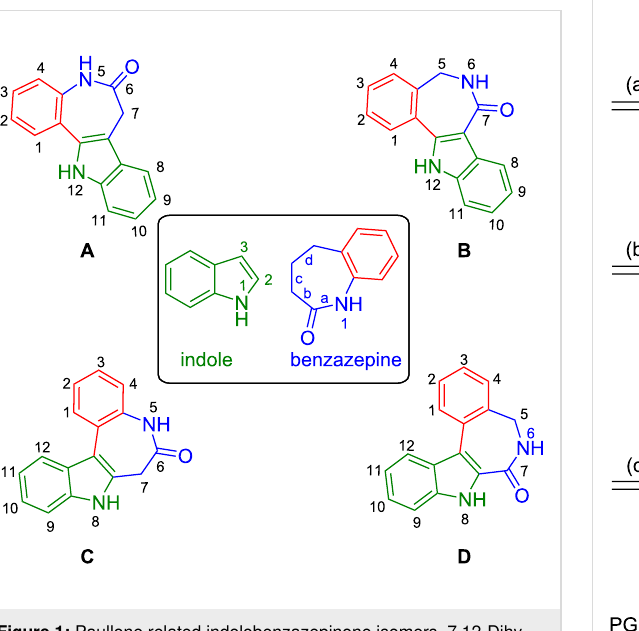
Figure 1: Paullone related indolobenzazepinone isomers. 7,12-Dihy- droindolo[3,2- d ][1]benzazepin-6(5 H )-one or paullone ( A ), 5,12-dihy- droindolo[3,2- d ][2]benzazepin-7(6 H )-one ( B ), 7,8-dihydroindolo[2,3- d ][1]benzazepin-6(5 H )-one ( C ), and 5,8-dihydroindolo[2,3- d ][2]benzazepin-7(6 H )-one ( D